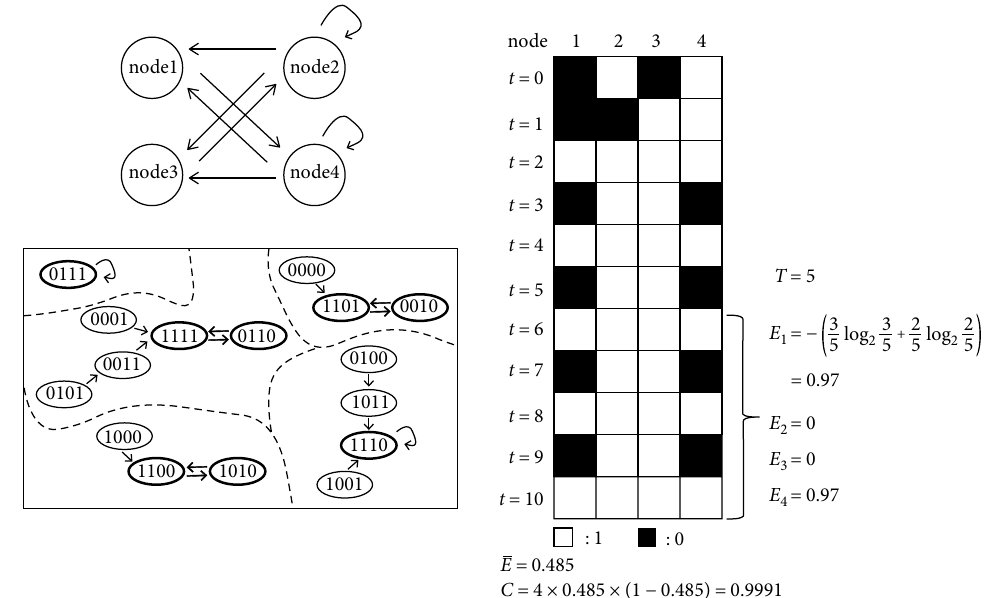
Figure 2: An example showing how to calculate complexity. Top‐left: a RBN with 𝑁 = 4 , 𝐾 = 2 . Bottom‐left: state space of the RBN. The state space is composed of 2 4 = 16 configurations and transitions among them. The configurations with bold outlines are attractors. Dashed lines draw boundaries for each basin of attraction. Right: state transitions and the computation of complexity, based on the emergence of each of the four nodes (columns). 0101 was used as an initial state. The state transitions were obtained from 𝑡 = 0 to 𝑡 = 10